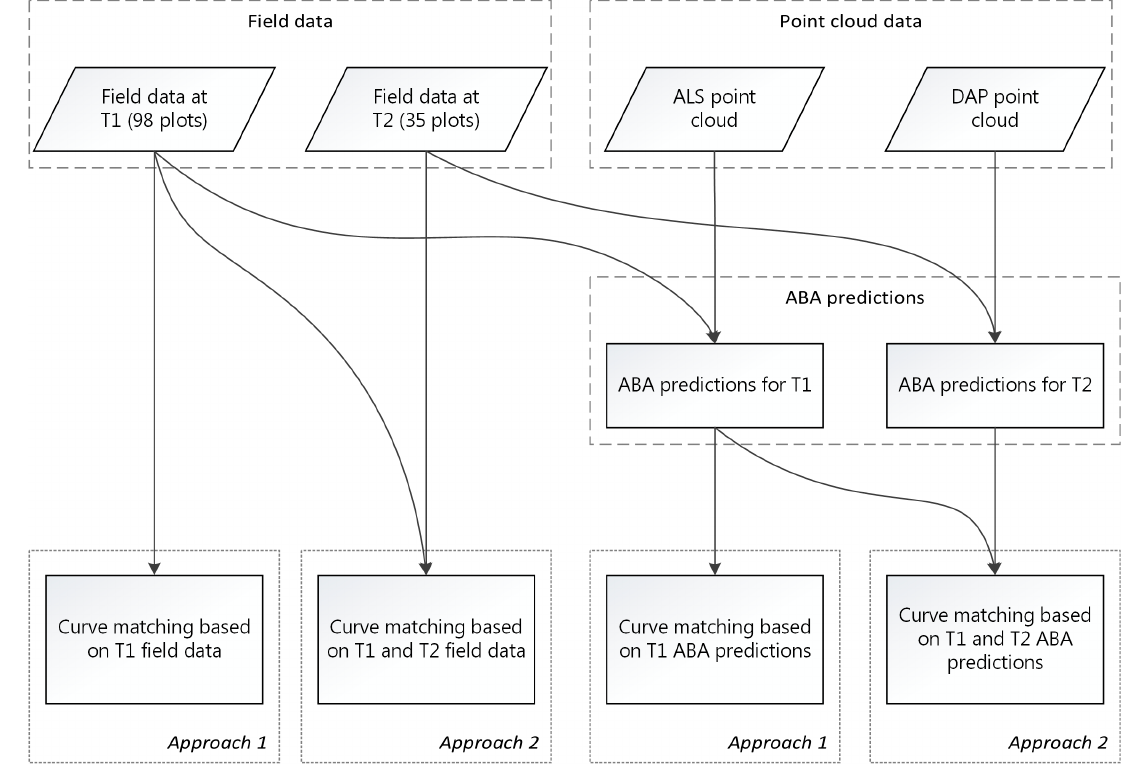
Figure 2. Overall study design and workflow.